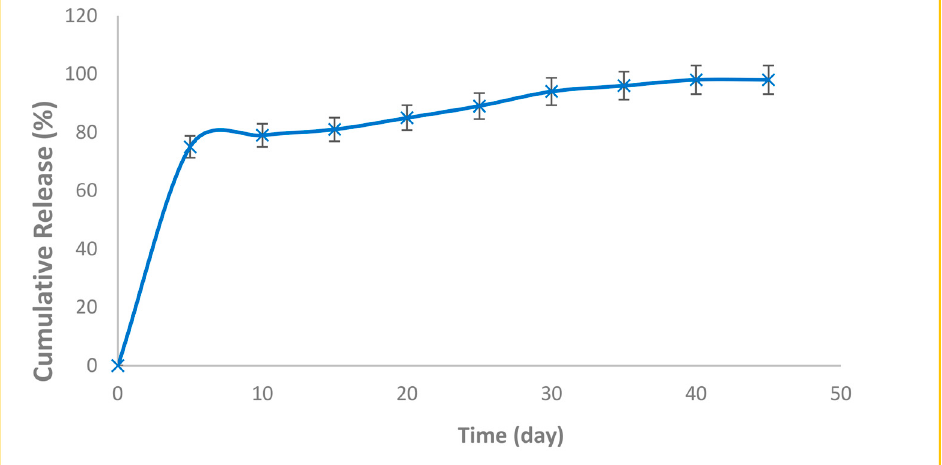
Figure 5. The release profile of curcumin-loaded silica